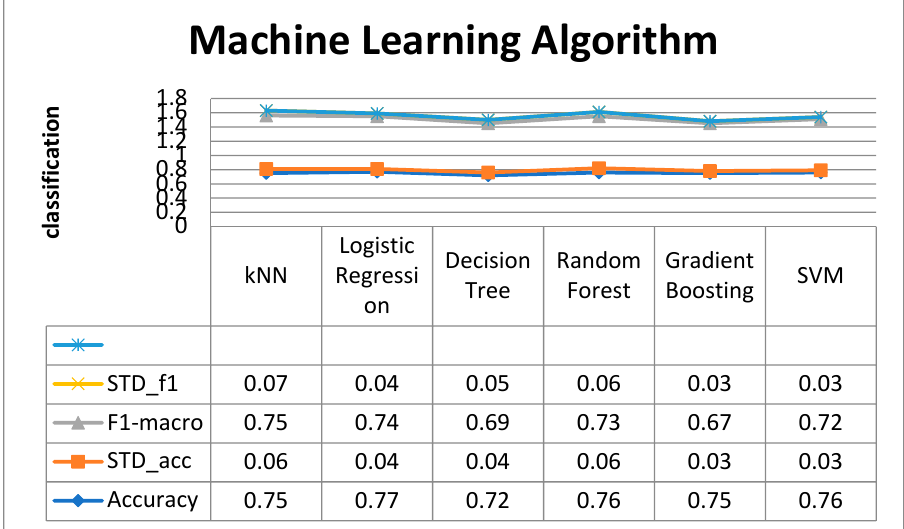
Figure 11. Comparison of classifiers. So, in this case, loss function is cross entropy. For y = 1 and y = 0, two equations will be applied. The fundamental tenet of this argument is that if my prediction is wildly off (for instance, when y’ = 1 and y = 0), the cost will be -log(0), which equals infinite. The